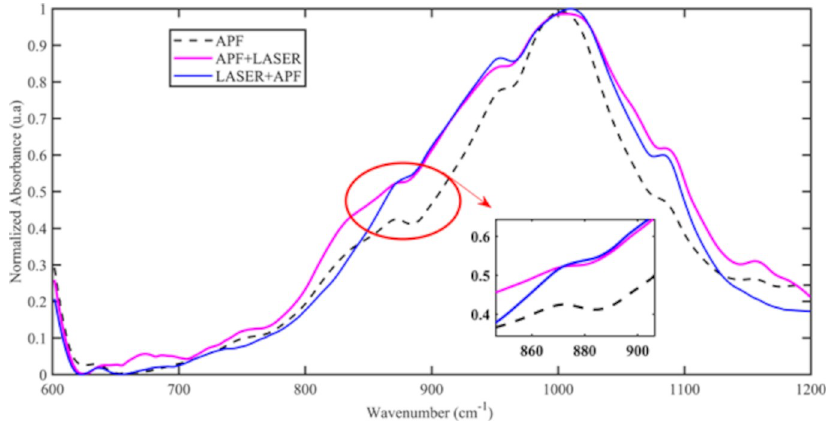
Fig 6. 5th day–average